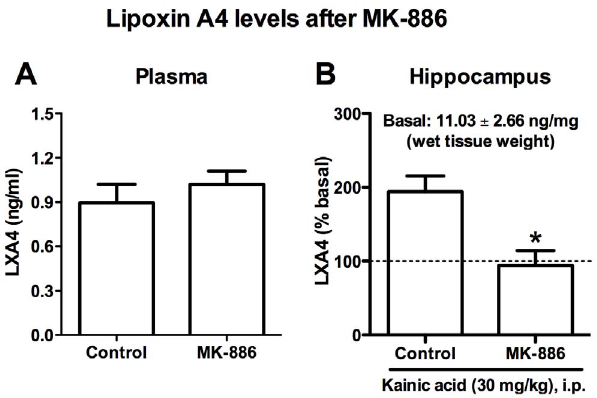
Figure 1. MK-886 prevents on demand synthesis of lipoxin A 4 in adult Swiss mice. Treatment with (MK-886 10 mg/kg, i.p.) did not reduce (A) basal circulating levels of lipoxin A 4 (n=8 2 12). However, (B) MK-886 (10 mg/kg, i.p.) successfully prevented the increase in lipoxin A 4 levels induced by kainic acid in the brain of adult Swiss mice (n=6 u 2 7). Data are presented as mean 6 SEM and were analyzed by two-tailed Student’s t test. In ‘‘B’’ data was normalized by basal levels found in control animals. *p , 0.05 vs control. LXA 4 : Lipoxin A 4 .